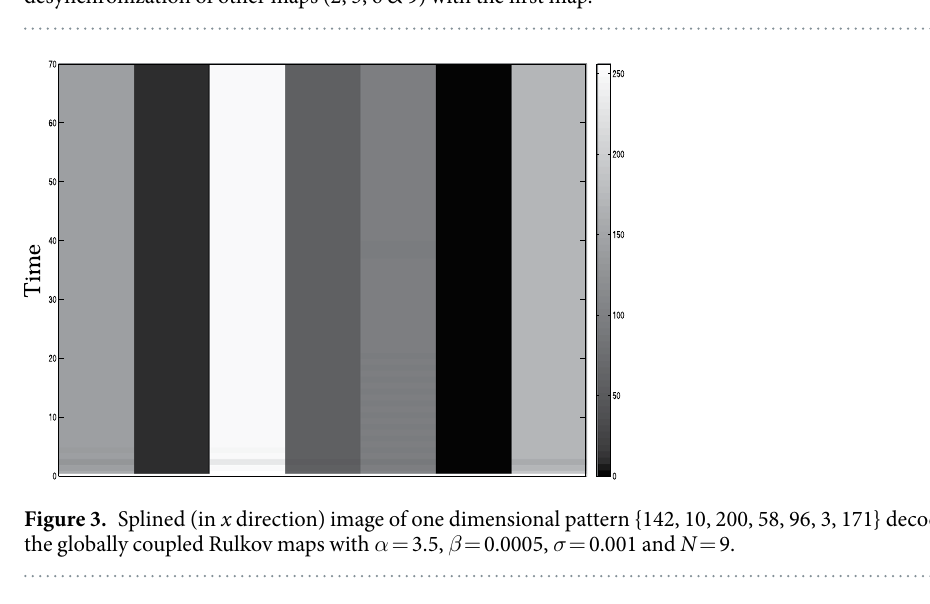
Figure 2. Targeted synchronization of coupled Rulkov maps where the synchronized value coincides with the average value x